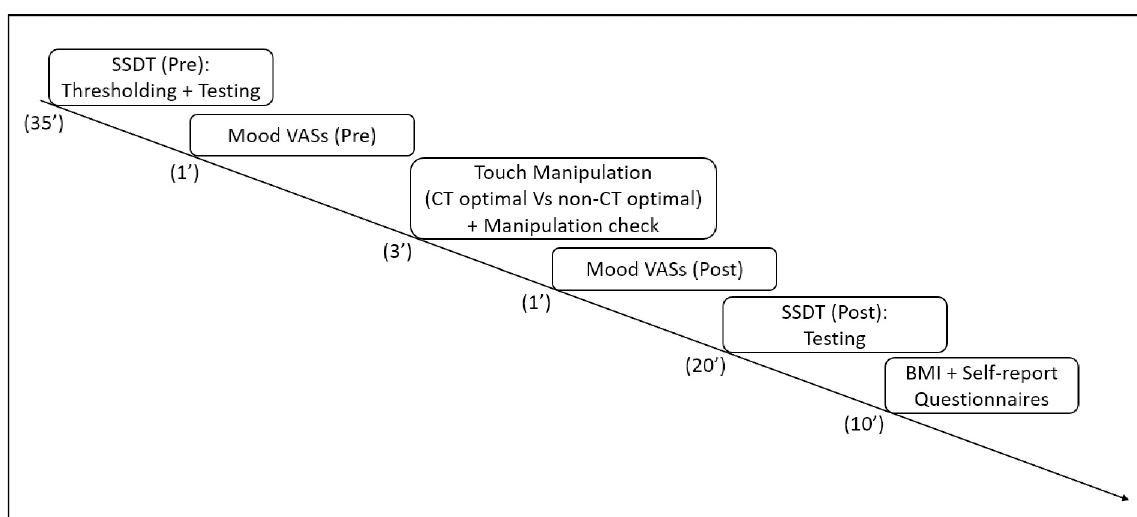
Fig 2. Timeline representation of the different steps of the study